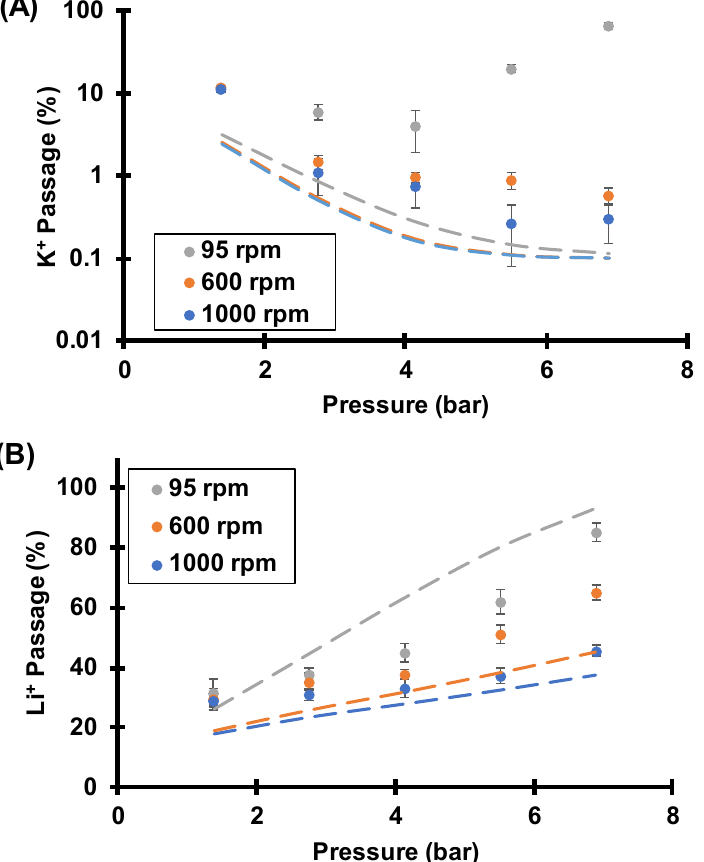
Figure 10. K + ( A ) and Li + ( B ) passages during flow of a 0.05 mM KCl, 0.05 mM LiCl mixture through track-etched membranes (30 nm pores) using various transmembrane pressures and membrane- rotation rates. Note that the upper plot uses a log-scale y -axis. Dashed lines are simulated passages assuming a surface charge density of − 2.2 mC/m 2 , a pore diameter of 30 nm, and a boundary layer thickness that is calculated from the Levich equation (Table 1). The simulation also incorporates a 0.1% membrane defect area.